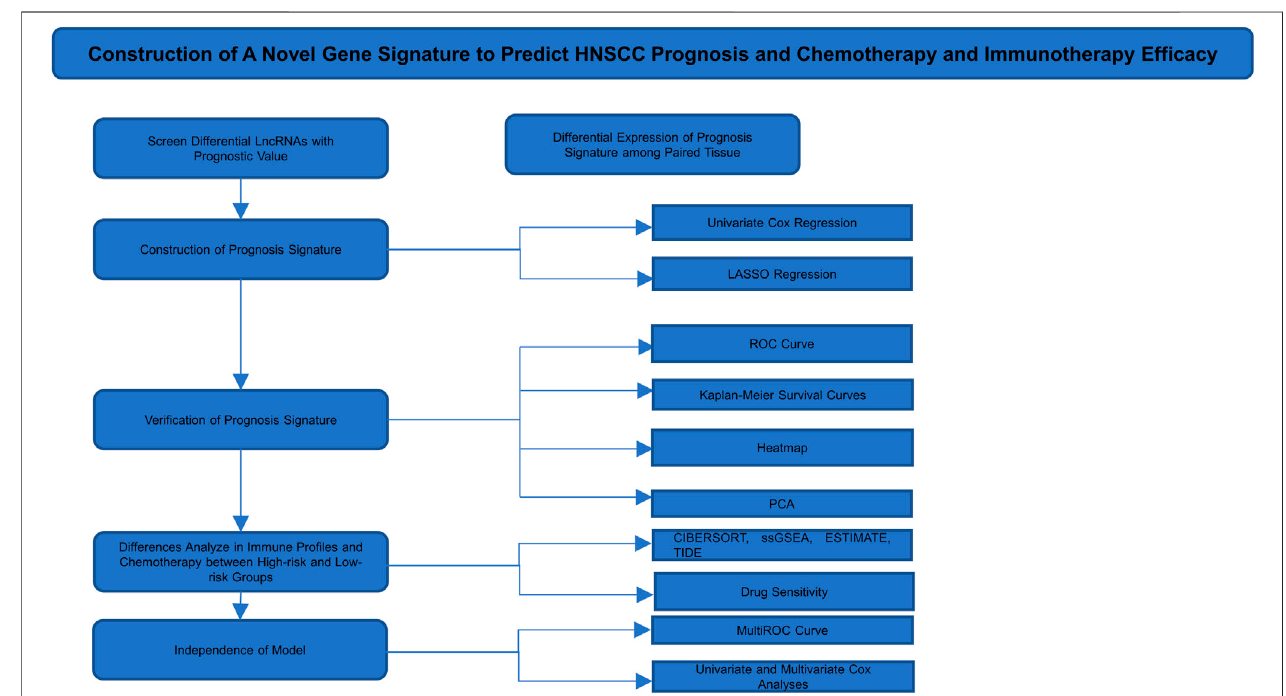
FIGURE 1 | Flow chart of the study